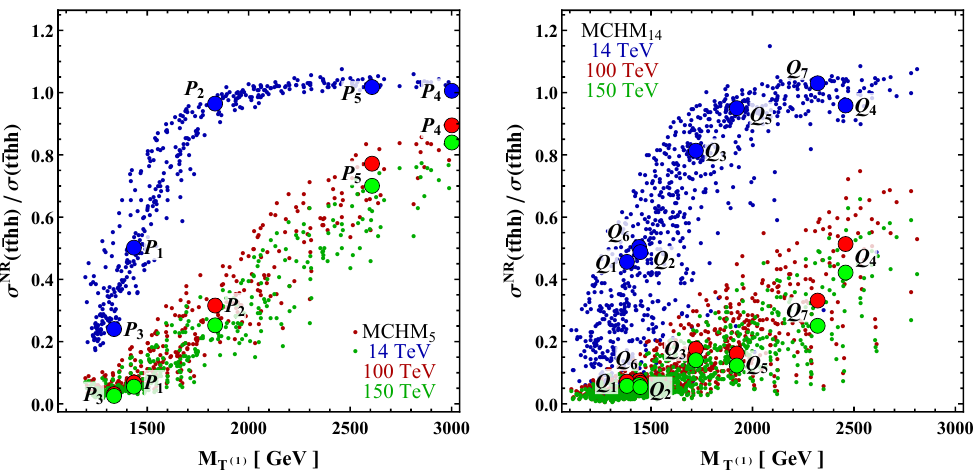
Figure 9 . Ratio between the non-resonant tthh cross section and the total tthh cross section as a function of the lightest Q = 2 / 3 vector-like mass, for 14, 100 and 150 TeV CM energies. The left (right) plots correspond to the MCHM 5 (MCHM 14 ).